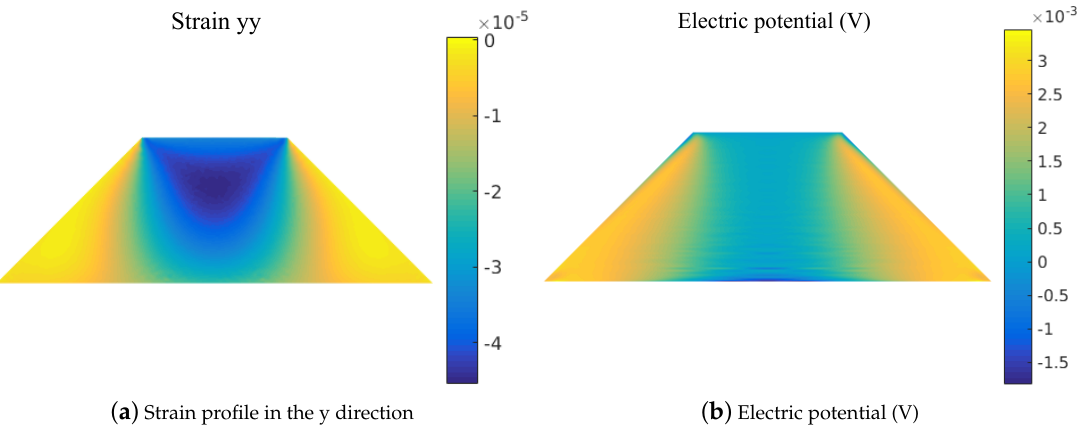
Figure 7. Calculation result of the compressed truncated pyramid: ( a ) strain profile in the y direction; ( b ) electric field